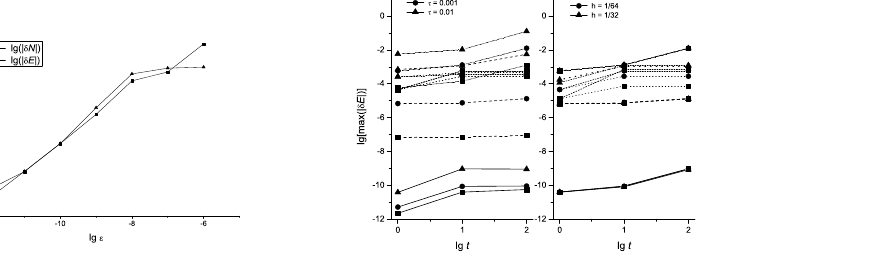
Figure 4. Logarithm of maximal deviations of invariants at g = 1 , k = 0 . 1 , for different values of ε .